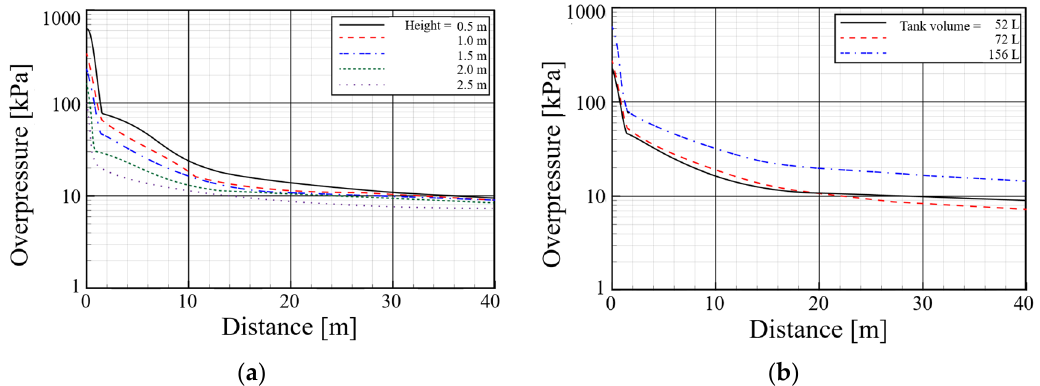
Figure 14. Explosion simulation results at underground parking lot: ( a ) overpressure according to height (52 L tank); ( b ) overpressure according to tank volume (1.5 m height).